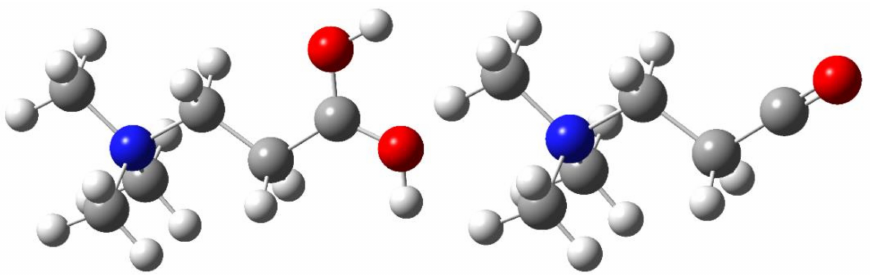
Figure 2. Active species in Watson ( left ) and Ingold ( right ) mechanisms in the case of betaine 2 . Color scheme: gray, C; blue, N; red, O; white,